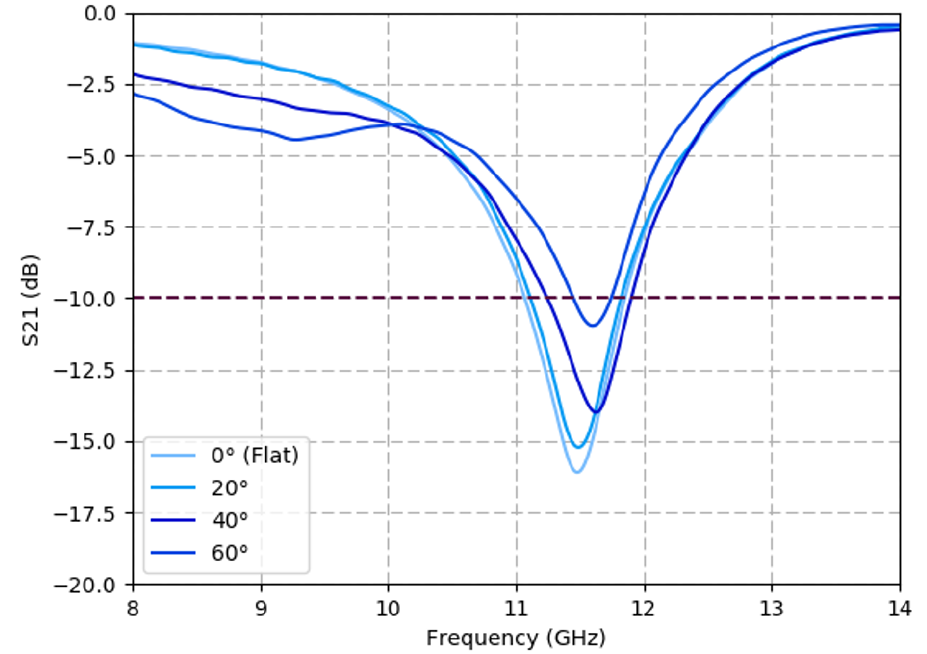
Figure 9. Miura-ori FSS maintains filtering performance under folding. Experimental transmission coefficient (S21) results of a Miura-ori spiral FSS, with a triangular lattice, at various fold states ranging from β = 0° (flat) to 60°. The operational folding range is equivalent to a 50% decrease in FSS